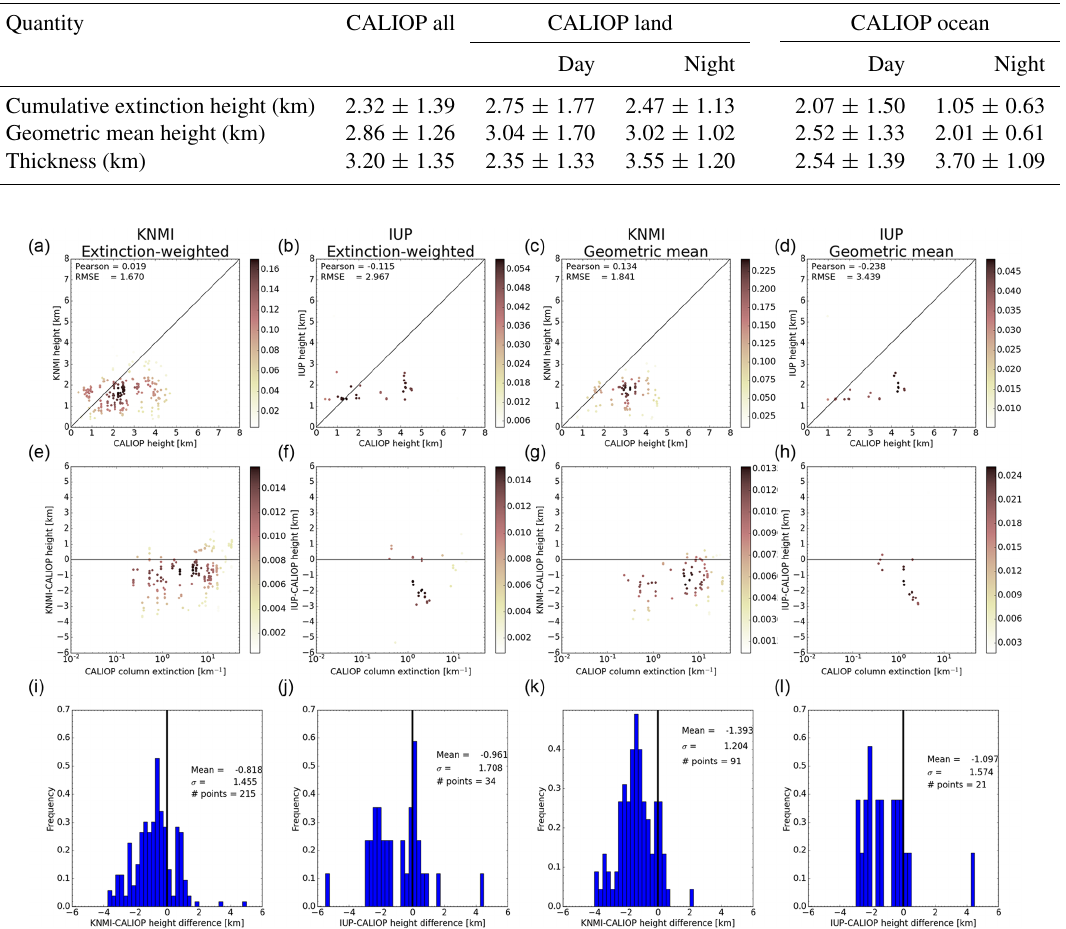
Table 4. CALIOP mean cumulative and geometric mean dust-layer height ± standard deviation together with the dust-layer thickness ± standard deviation. Statistics are given for the full data set and for subsets divided into land and ocean for day and night overpasses.